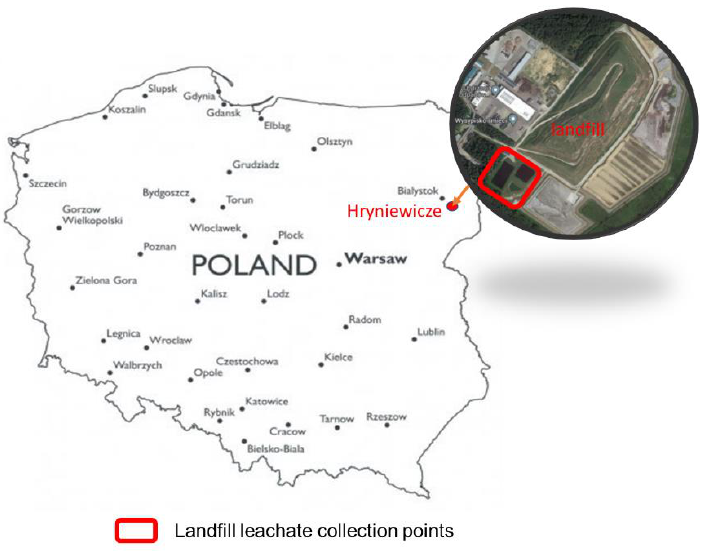
◦ 4 (cid:48) 48” N, 23 ◦ 8 (cid:48) 7” E) and sampling site of